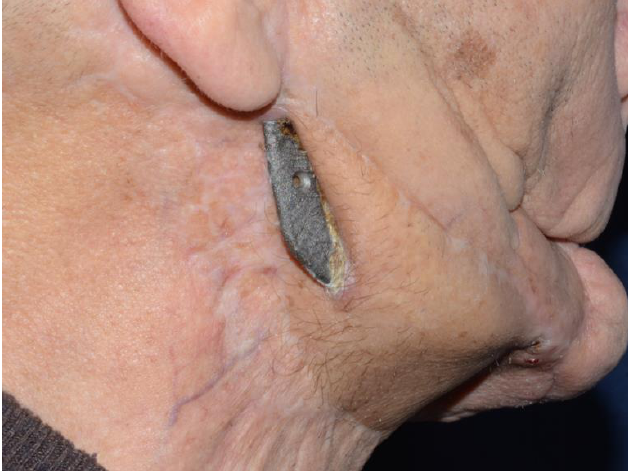
Figure 7. CBMP exposure in a case of ORNJ.